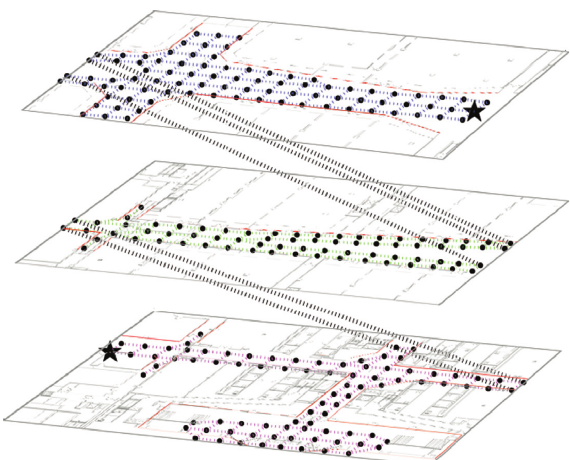
Figure 3: The graph representative of a Canary Wharf Shopping Mall. The black stars represent the